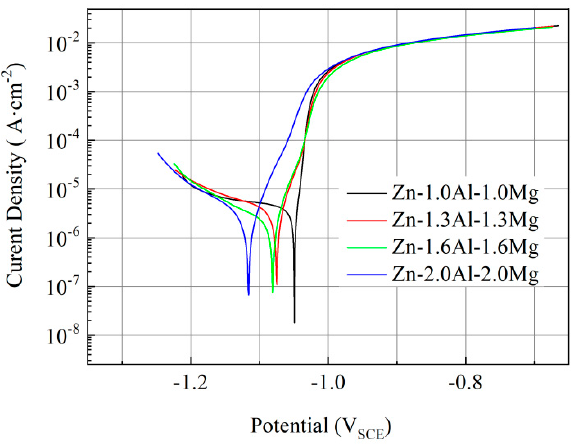
Figure 9. Dynamic polarization curve of experimental coatings in 3.5% NaCl solution. Table 2. Corrosion potential and corrosion current density of experimental coating. Coatings